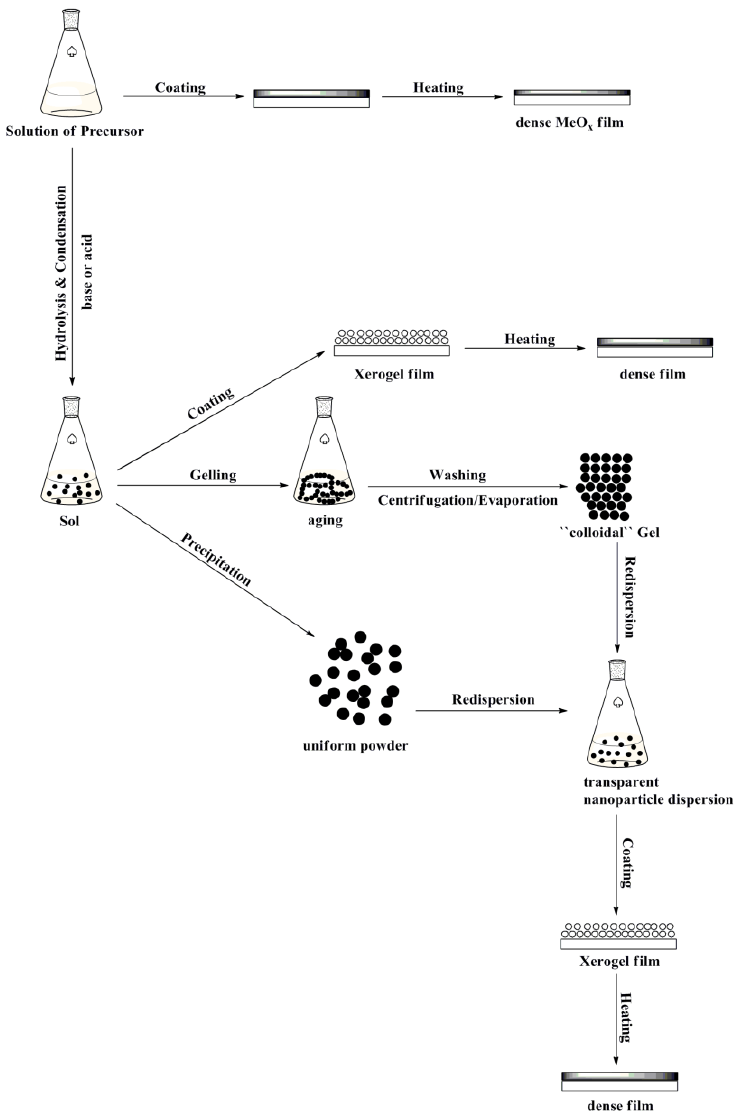
Figure 1. Various sol-gel options to control the final morphology of the different